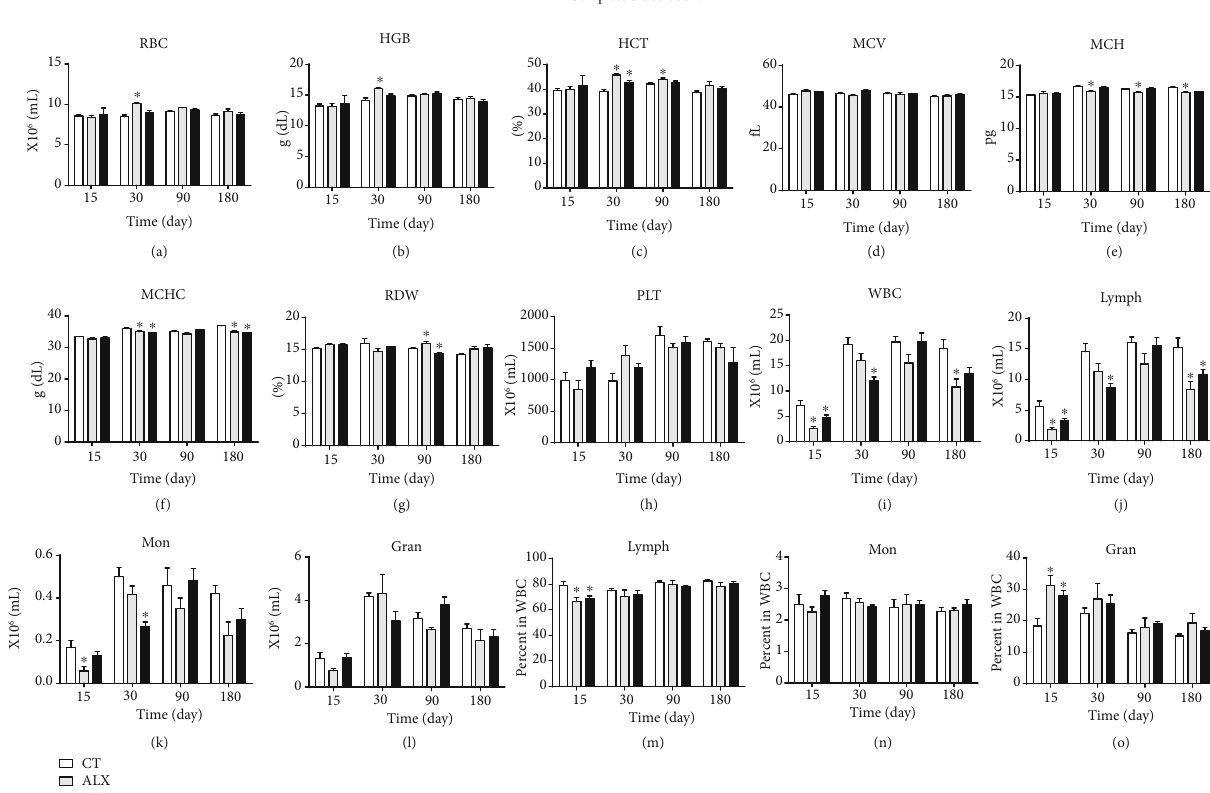
Figure 2: STZ e ff ects on hematimetric parameters of immunological cells in the early phase of T1D are restored in the chronic phase of the disease. T1D was induced as described in Methods, and blood samples were collected in EDTA on the 15 th , 30 th , 90 th , and 180 th days, to evaluate the following parameters: (a) red blood cells; (b) hemoglobin; (c) hematocrit; (d) mean corpuscular volume; (e) mean corpuscular hemoglobin; (f) mean corpuscular hemoglobin concentration; (g) red cell distribution width; (h) platelets; (i) leukocytes; (j) lymphocytes; (k) monocytes; (l) granulocytes; (m) percentage of lymphocytes; (n) percentage of monocytes; (o) percentage of granulocytes. Data are presented as mean ± SEM , ∗ p < 0 : 05 (11-13 animals per